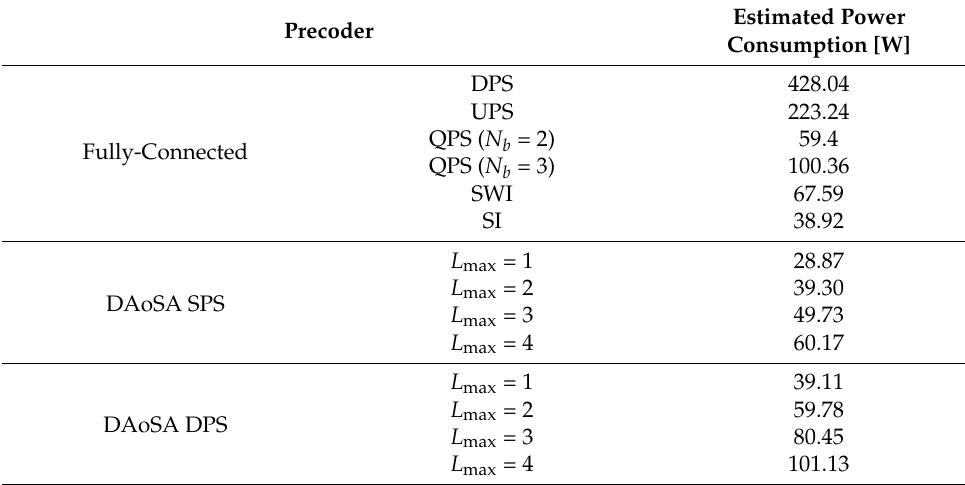
Table 3. Power Consumption for Different Implementations of the Proposed Precoder for N u = 4, = 8, F = 1, N tx = N s = 2, N tx RF